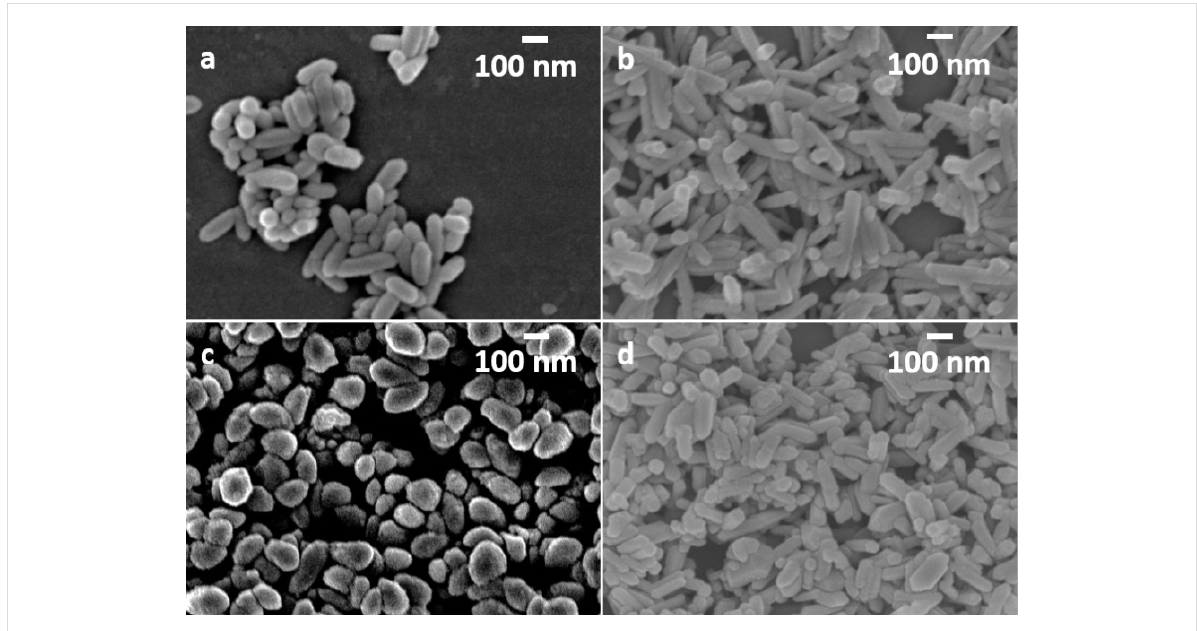
Figure 5: FESEM images of α -Fe 2 O 3 nanoparticles obtained with a) ethylenediamine, b) 1,2-diaminopropane, c) N -methylethylenediamine and d) 2,3-diaminobutane, where the Fe 3+ concentration was kept at 1.5 M, magnification: 50,000.